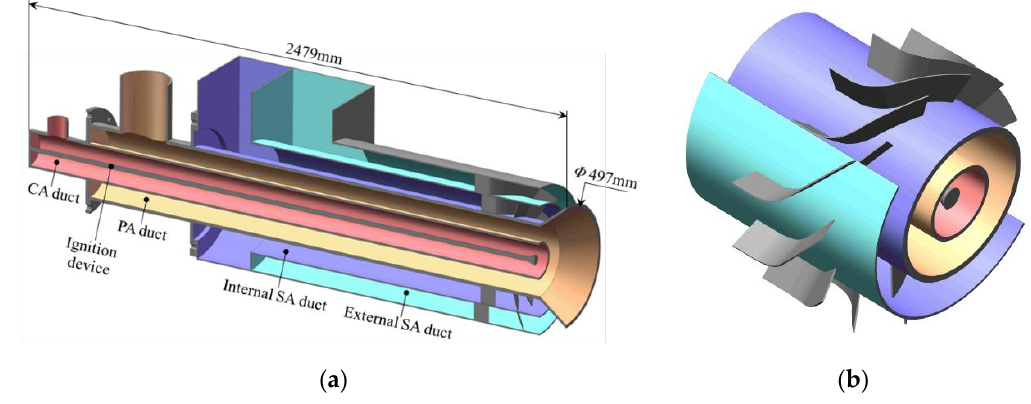
Figure 1. Schematic diagram of swirl burner. ( a ) Structure of swirl burner; ( b ) Vane geometry.